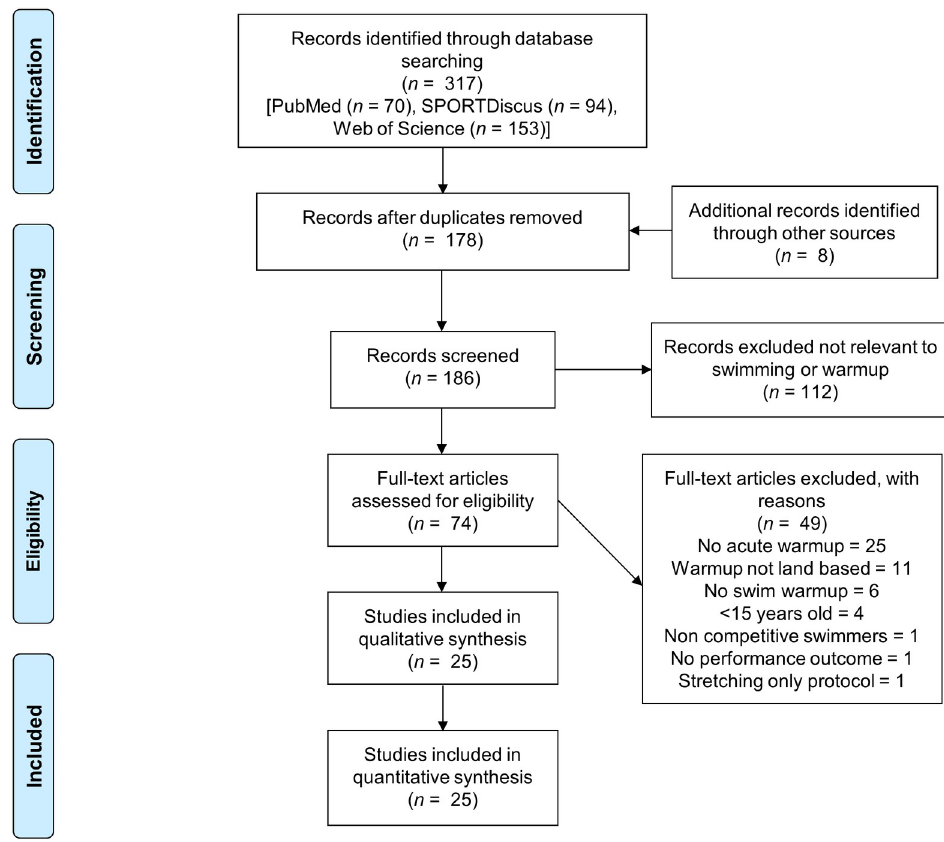
Fig 1. PRISMA diagram. Study selection